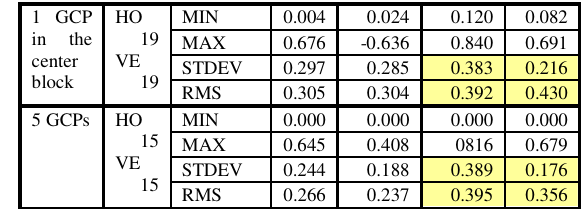
Table 4. Comparison of Direct Geo-referencing with